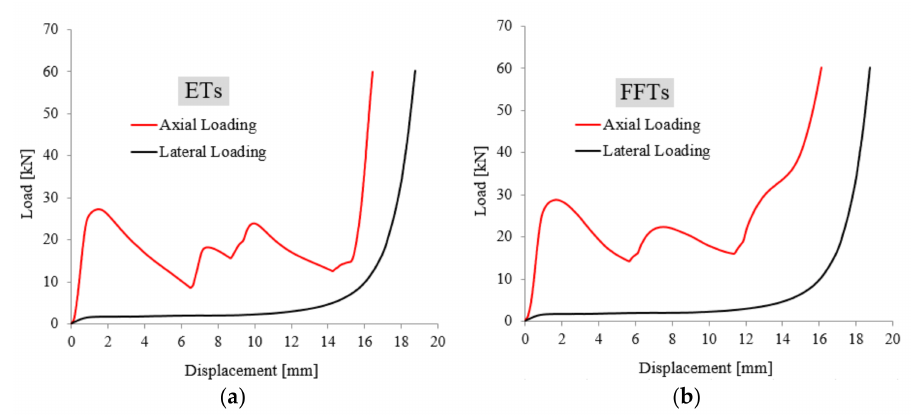
Figure 5. A comparison of axial and lateral load-displacement curves for both ETs ( a ) and FFTs ( b ) sample configurations.